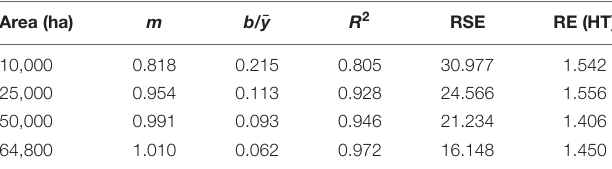
TABLE 1 | Regression results ( y = mx + b ) of the scatterplot of GREG ( x ) vs. HT ( y ) estimates across spatial scales, along with median relative standard error (% of estimate) and median RE of the GREG vs. HT estimator.